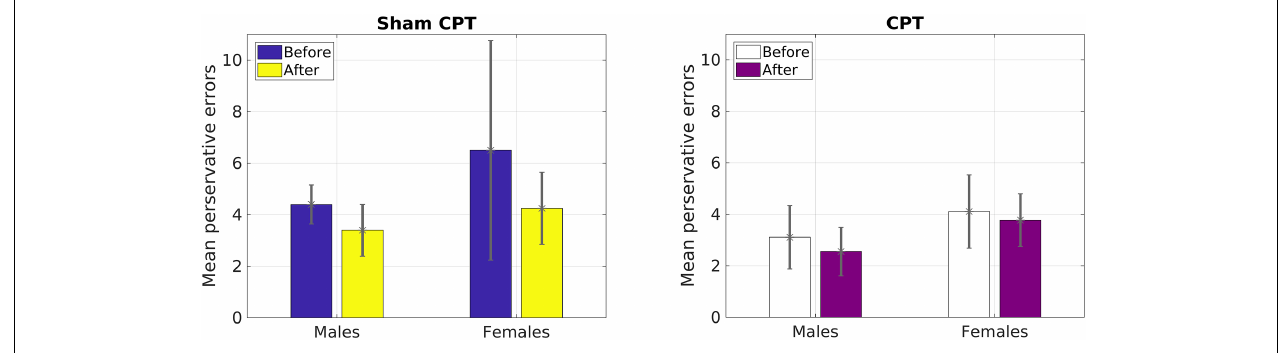
FIGURE 4 | Mean number of perseverative errors as a function of sex and condition for Study